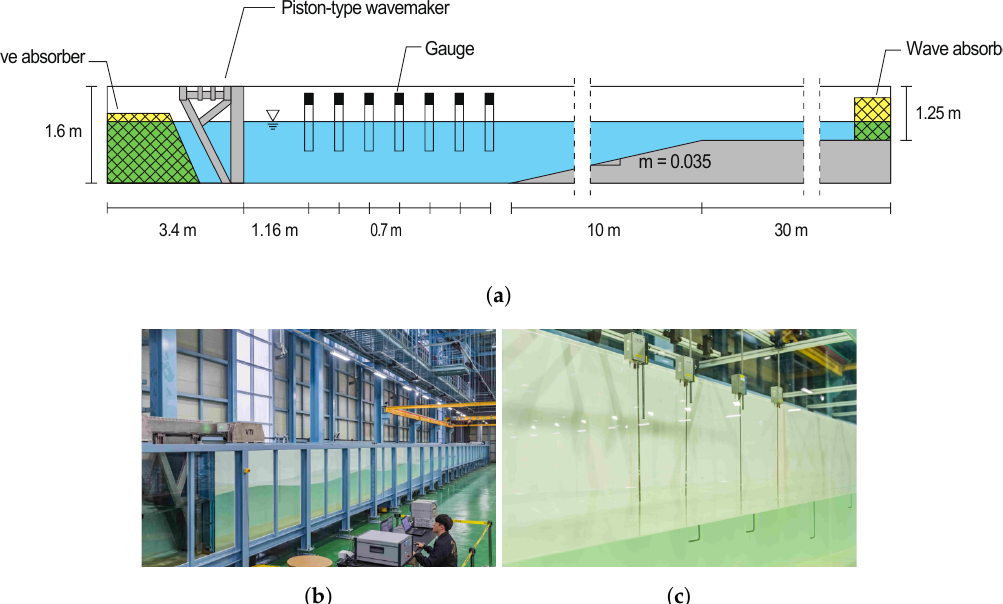
Figure 11. ( a ) Schematic of the experimental wave flume, ( b ) experimental wave flume at KIOST [54], and ( c ) capacitance type wave